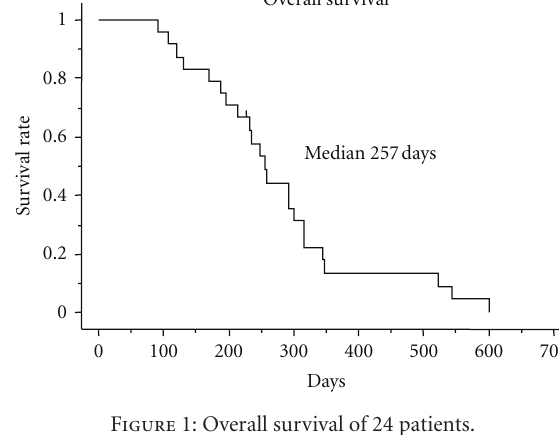
Figure 1: Overall survival of 24 patients.